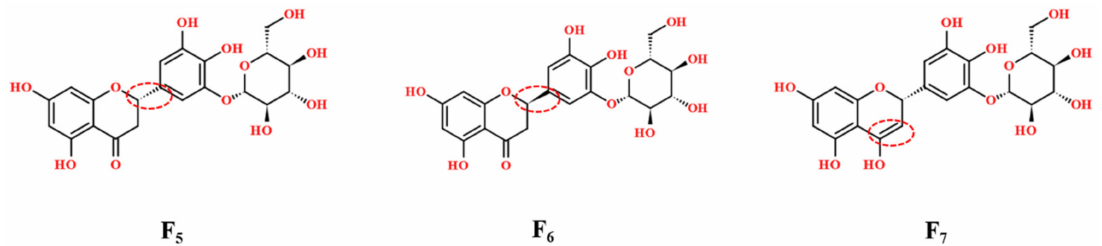
Figure 7. Drift times distribution of compounds 32 , 33, and 34 : ( A ) the PH of mobile phase is less than 7; ( B ) the PH of mobile phase is greater than 7.